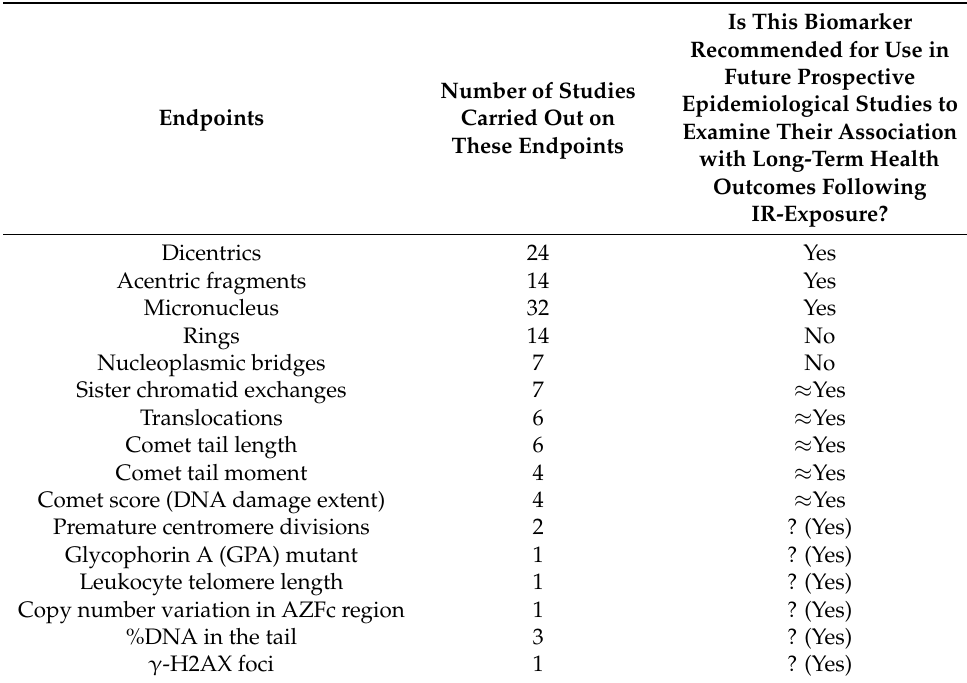
Table 3. Summary of the biomarkers used in the included